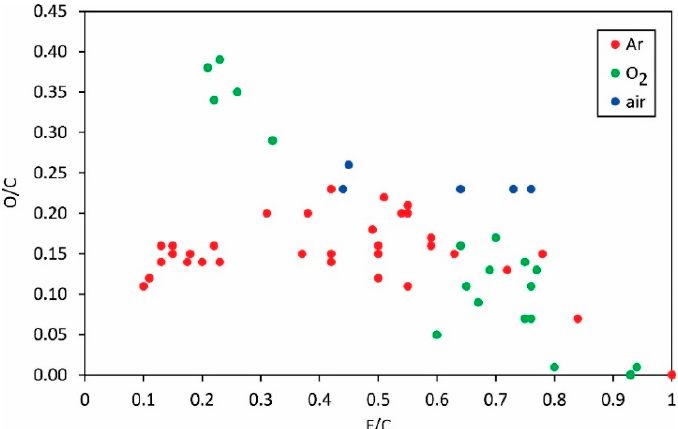
Figure 4. The O/C ratio versus the F/C ratio.